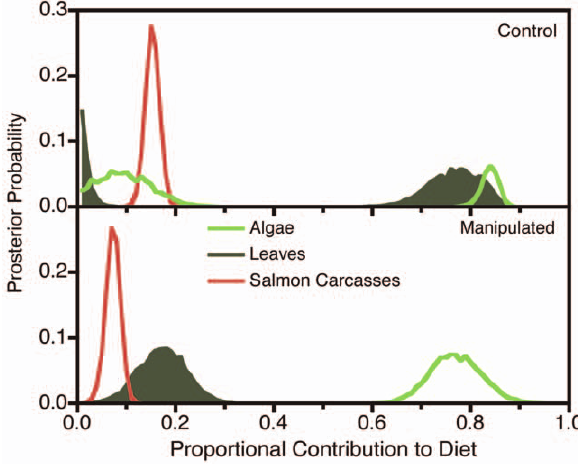
Figure 4. Estimated Contributions of Different Energy Sources Entering the River to Juvenile Salmonids Based on Stable Isotope Analysis. Graphs show Bayesian posterior probabilities of different fractional diet compositions, derived from the MixSIR algorithm [65], assuming a two trophic level energy transfer to salmon via aquatic invertebrates. Top: control reaches. Bottom: treatment with reduced riparian vegetation.